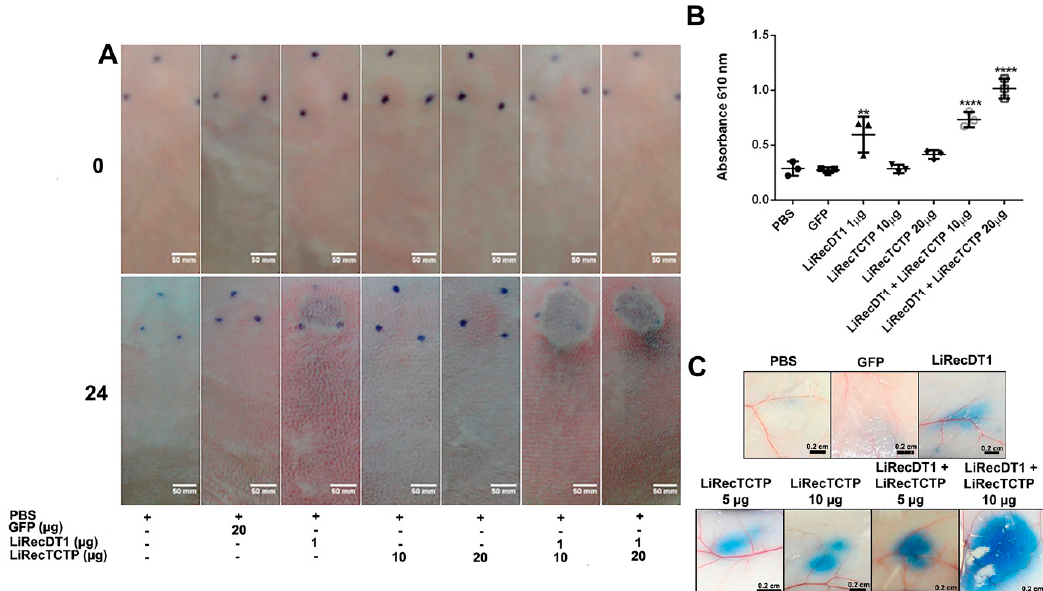
Figure 6. Inflammatory response of combined recombinant toxins (LiRecTCTP and LiRecDT1) in vivo . ( A ) Macroscopic evaluation of rabbit skin exposed to recombinant toxins (LiRecTCTP, LiRecDT1, or